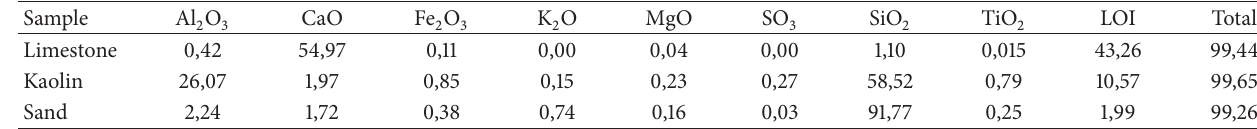
Table 1: Average chemical composition of raw materials used for the production of white clinker.